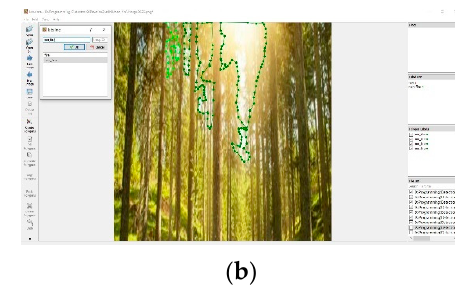
Figure 3. Image annotation; ( a ) fire, ( b ) non-fire.